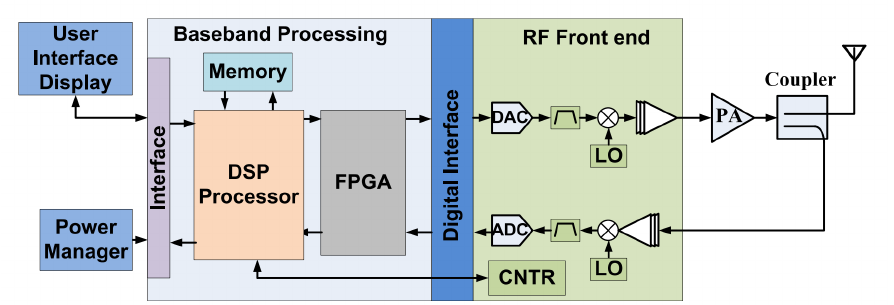
Figure 1. General scheme of an SDR device. Two general stages are identified, the first is the RF-front- end, and the second is the baseband processing stage. FPGA is the closest hardware accelerator to the RF-front-end; it is here where DL algorithms can be downloaded to fulfill specific CR tasks. Taken from